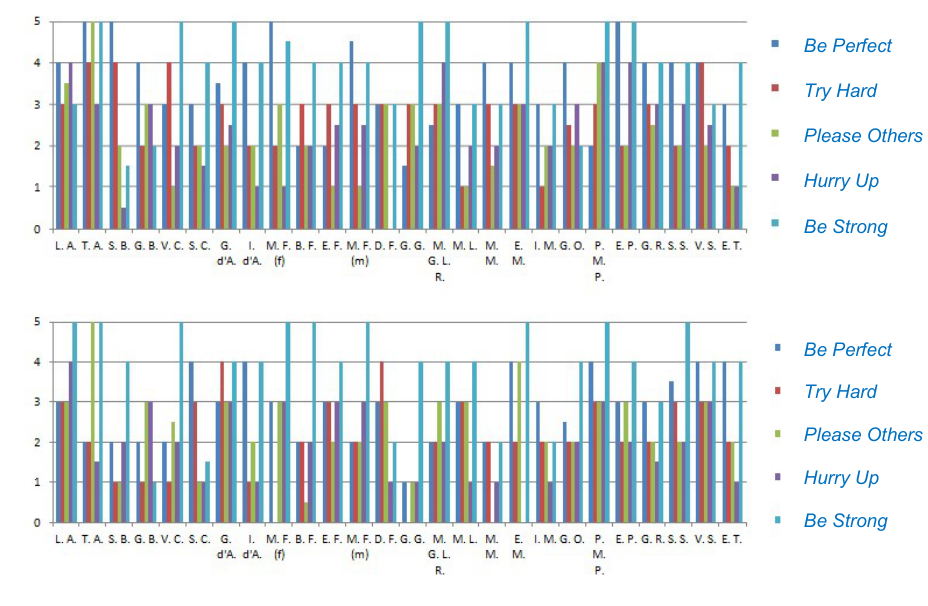
Figure 8: Changes in behavioural